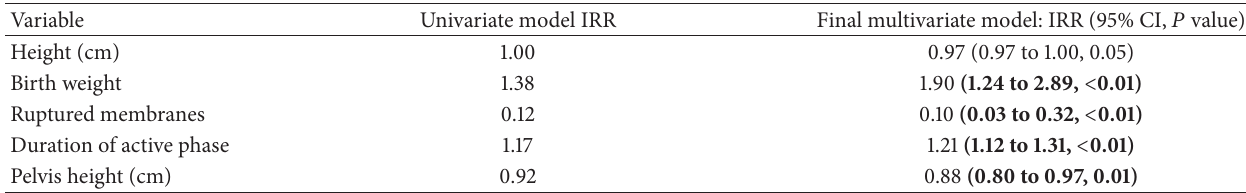
Table 4: Multivariate regression model for foetal head moulding by the different study